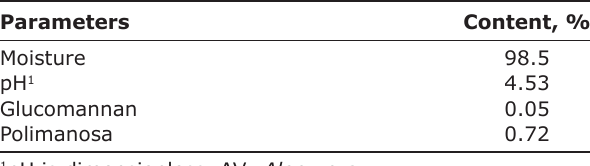
Table-1: Chemical characterization of AV